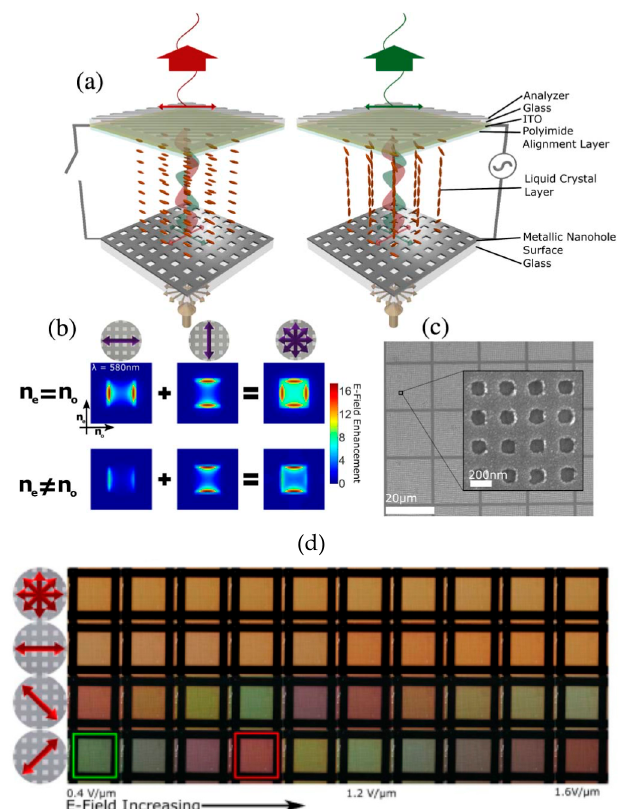
Figure 10. ( a ) Schematic of the LC plasmonic device without and with applied voltage. ( b ) FDTD simulation results of two orthogonal resonance modes. ( c ) SEM image of nanohole array fabricated in Al thin film. ( d ) Appeared color of nanohole arrays under different applied voltages. Adapted from [140], with permission © 2017 Optical Society of America.